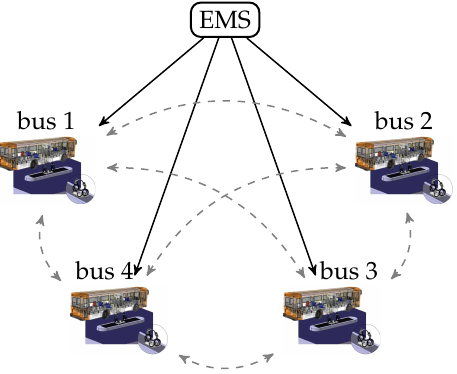
Figure 3. Scheme of the considered NAIMD-based architecture with four